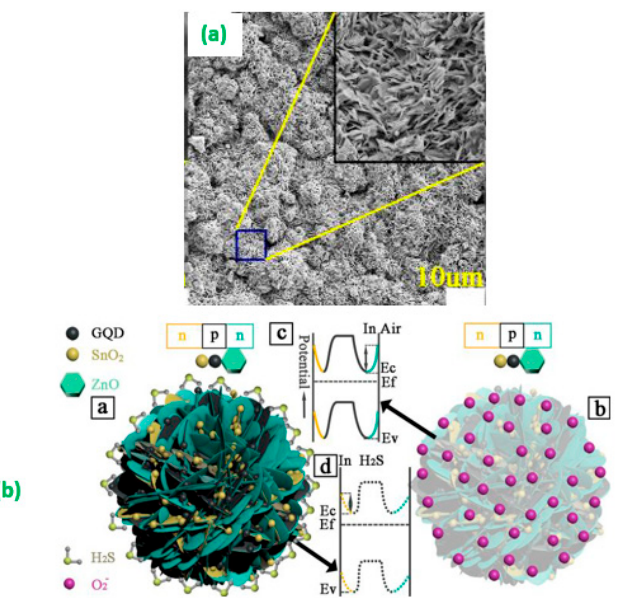
Figure7. ( a )SEMimagesofGQD-SnO 2 / ZnOnanosheetwith6hpsHTand( b )schematicdiagramofband Figure 7. ( a ) SEM images of GQD-SnO 2 /ZnO nanosheet with 6 h psHT and ( b ) schematic diagram of configuration at the interface of GQD-SnO 2 / ZnO nanostructure in di ff erent atmospheres. Reproduced band configuration at the interface of GQD-SnO 2 /ZnO nanostructure in different atmospheres. from Shao, S.; Chen, X.; Chen, Y.; Zhang, L.; Kim, H.W. and Kim, S.S., 2020. ZnO Nanosheets Reproduced from Shao, S.; Chen, X.; Chen, Y.; Zhang, L.; Kim, H.W. and Kim, S.S., 2020.ZnO